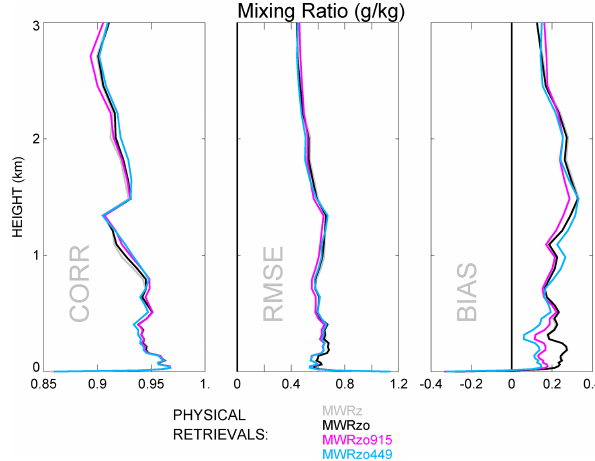
Figure 7. Same as the panels in Fig. 6b, but for mixing ratio, when using the TROPoe BC method on the MWR T b